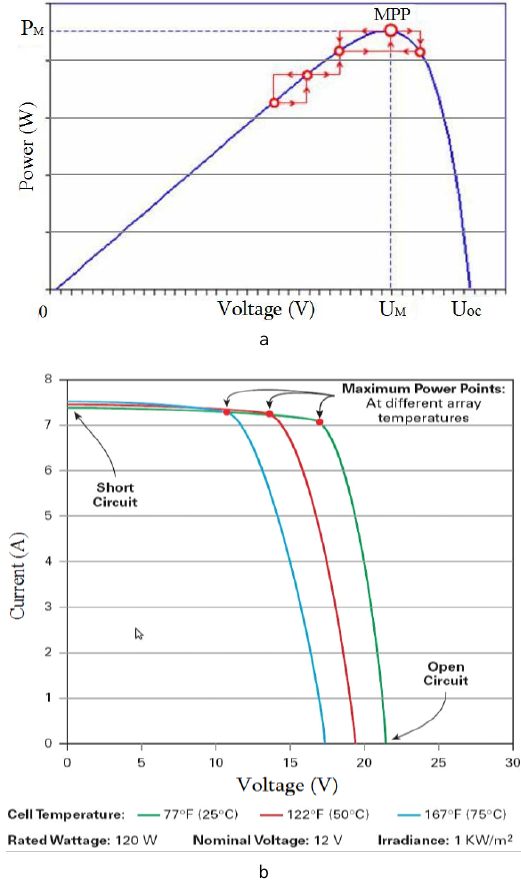
Fig. 2. Maximum Power Point: a – determination of MPP; b – MPP depending on the temperature of a PV panel [9]. Fig. 2b shows how the voltage in MPP can change with different module temperatures. The higher the temperature of the solar module, the less voltage is on the module and, consequently, the generation of energy by PV panel. At certain moments, the point of maximum power can be lower than the voltage on the battery, and in this case the operation of MPPT controller will be ineffective (in terms of power generation) compared with the PWM controller. Shading of a PV panel has the same